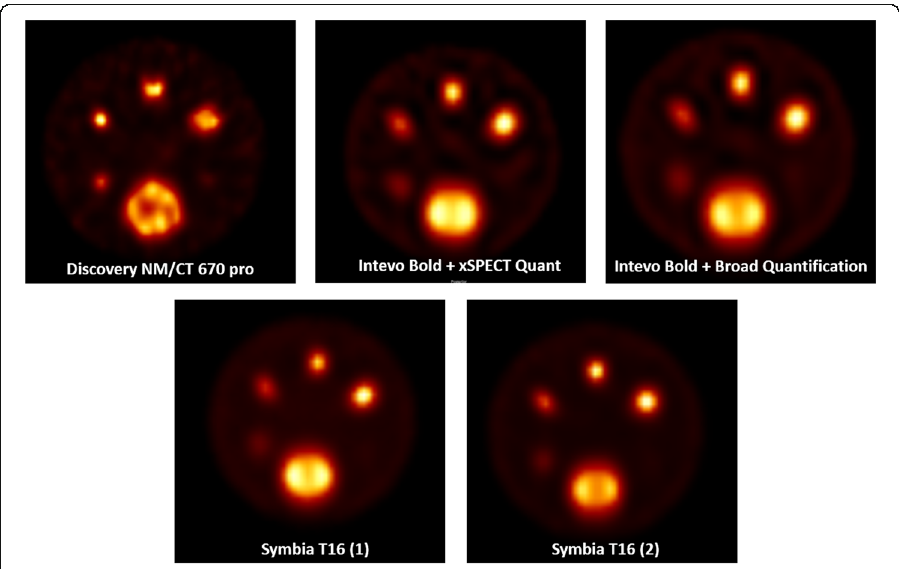
Fig. 2 SPECT images of the cylindrical phantom for all systems, reconstructed with vendor-specific reconstruction